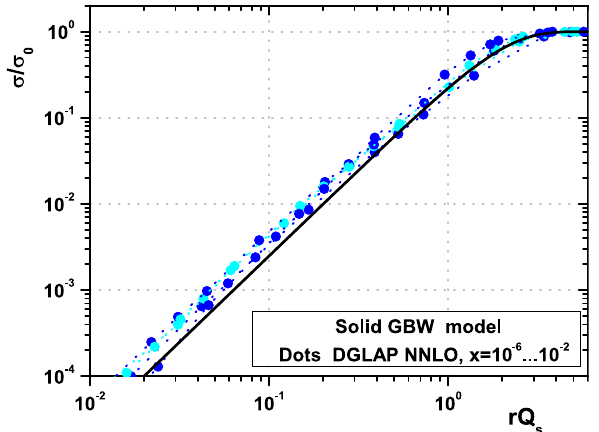
Fig. 7 The same as Fig. 4 within the NNLO